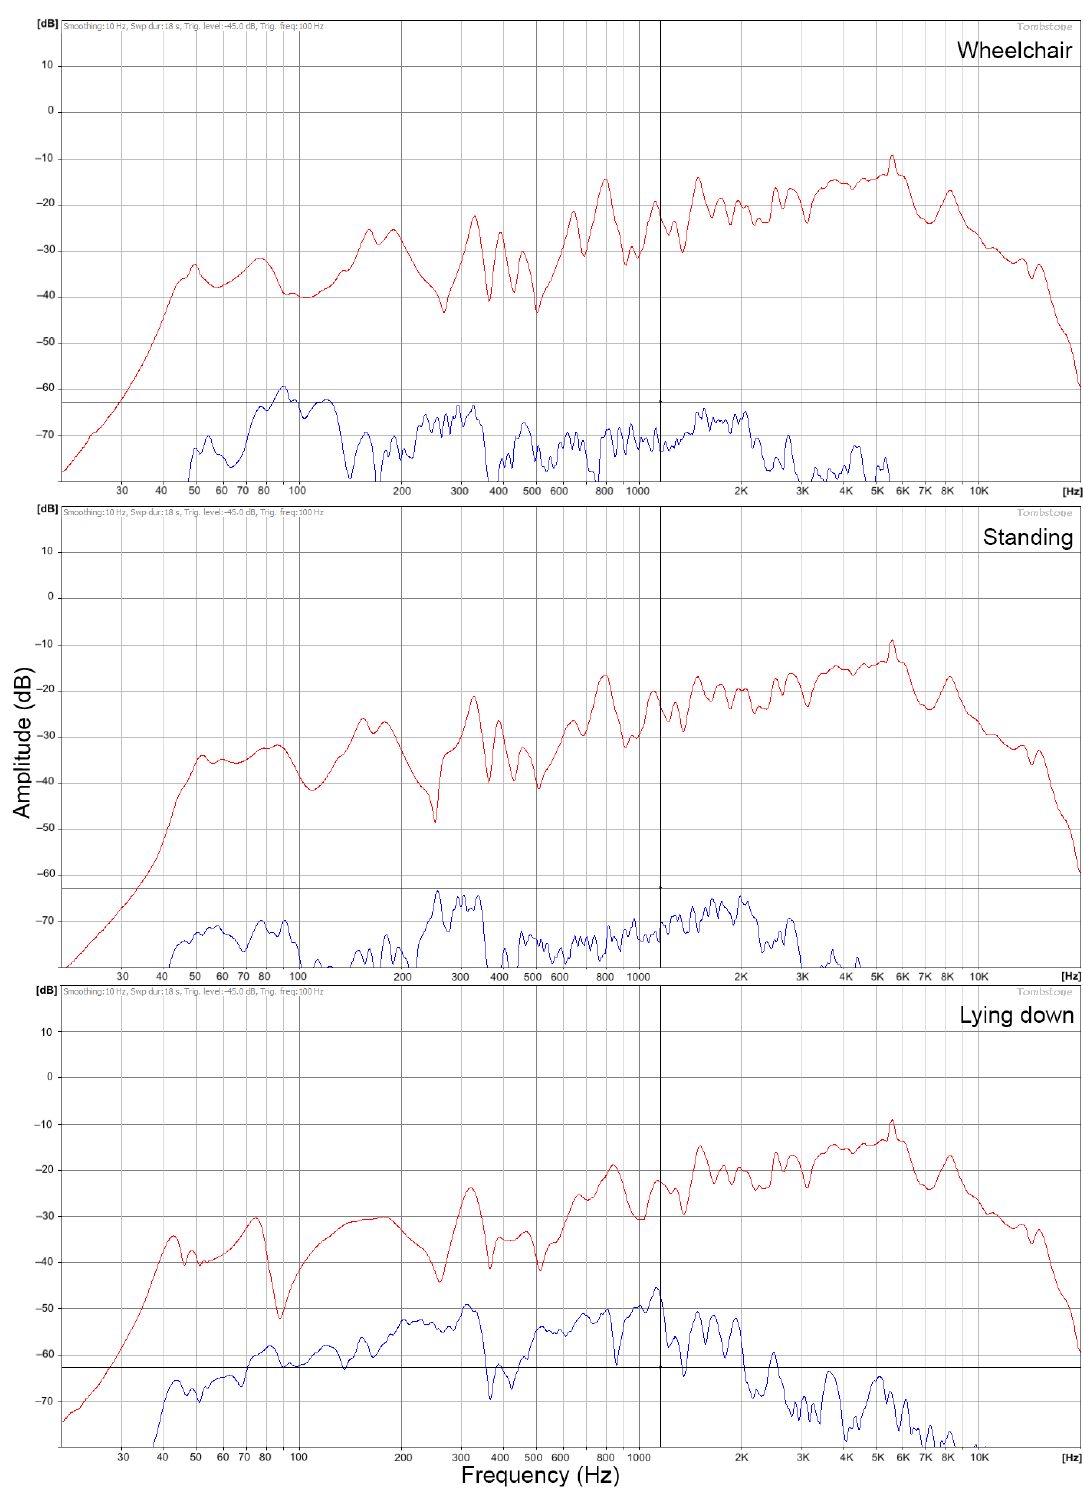
Figure 7. Results from accelerometer measurements on one of the small platforms in Sound Forest, with a researcher sitting in a wheelchair placed on the platform ( top ), standing on the platform ( middle ), and lying down on the platform ( bottom ). The red curve corresponds to audio captured using a microphone placed next to the ear. The blue curve corresponds to the signal recorded by the